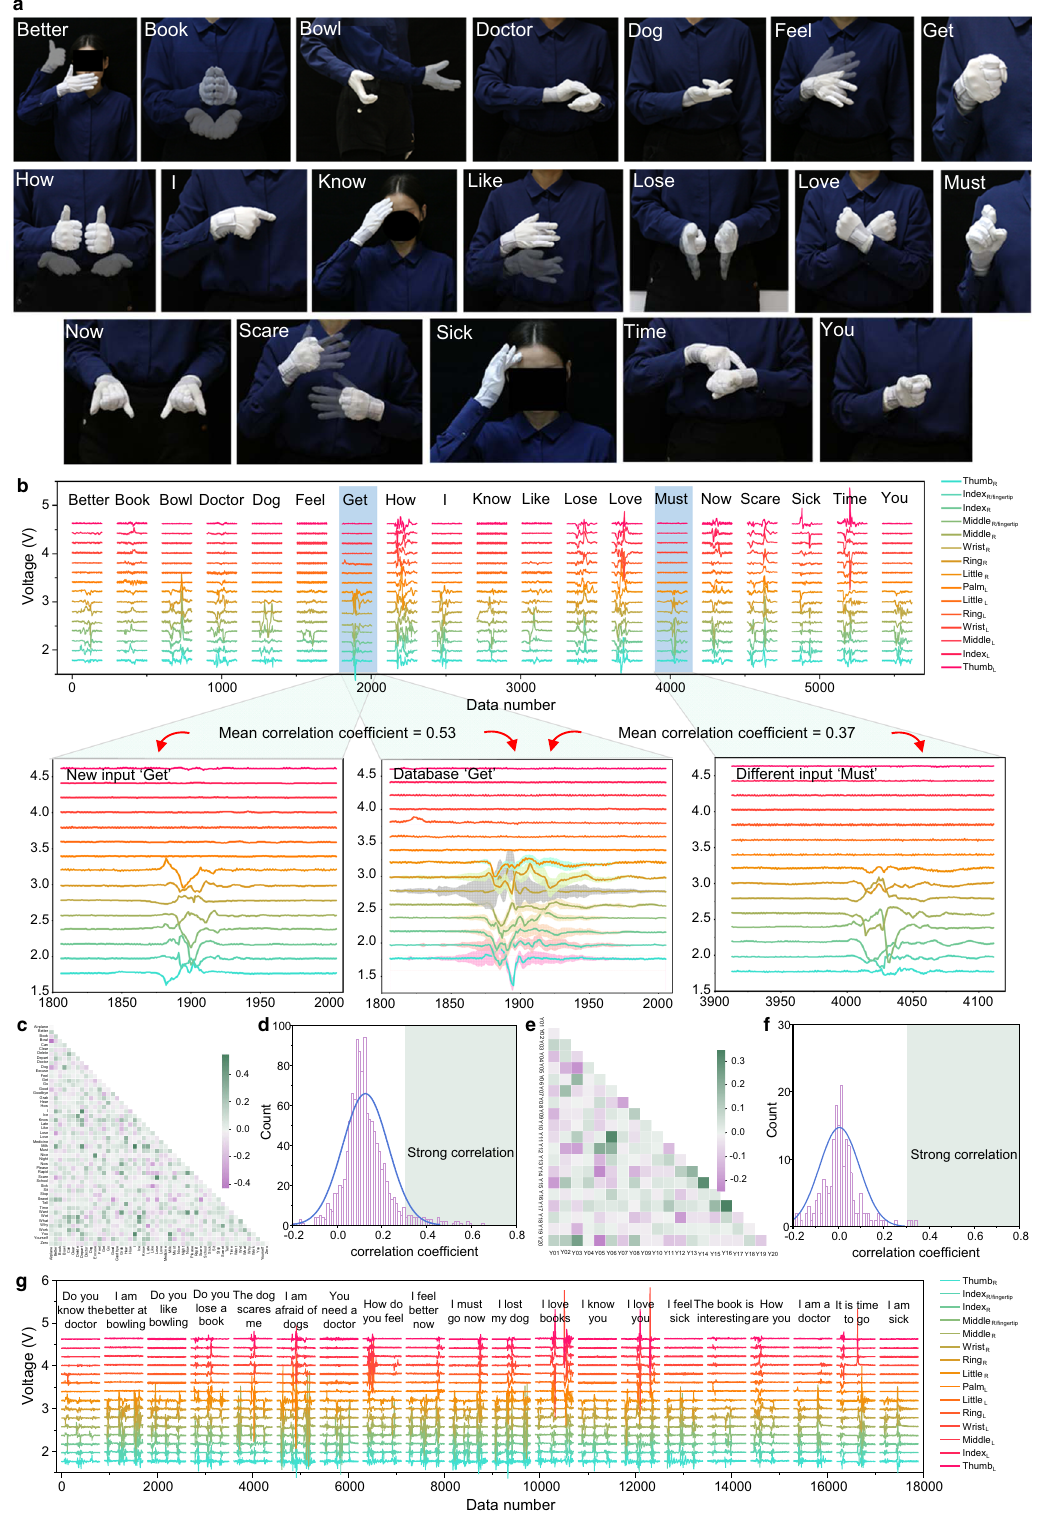
Fig. 2 The data analysis for signals of 50 words and 20 sentences. a Part of representatives among 50 words or gestures (showing 19 gestures here), in which the opaque and translucent gesture images show the starting and fi nal state of the gesture, respectively. The rest of 31 gesture photo and their corresponding triboelectric signals can be found in Supplementary Fig. 2. b Triboelectric voltage output of 19 words (top), and the similarity and correlation analysis based on the word signals (bottom). The high correlation coef fi cient of ‘ Get ’ and ‘ Must ’ shows a high similarity between these two gesture signals, indicating a high possibility for wrong classi fi cation. c Correlation coef fi cient matrix of signals of 50 words. d Correlation coef fi cient distribution curve of 50 words. e Correlation coef fi cient matrix of 20 sign language sentences. f Correlation coef fi cient distribution curve of 20 sentences. g Voltage output of 20 sentences. Photo credit: Feng Wen, National University of Singapore. Source data 65 of Figs. 2c, e are provided in Harvard